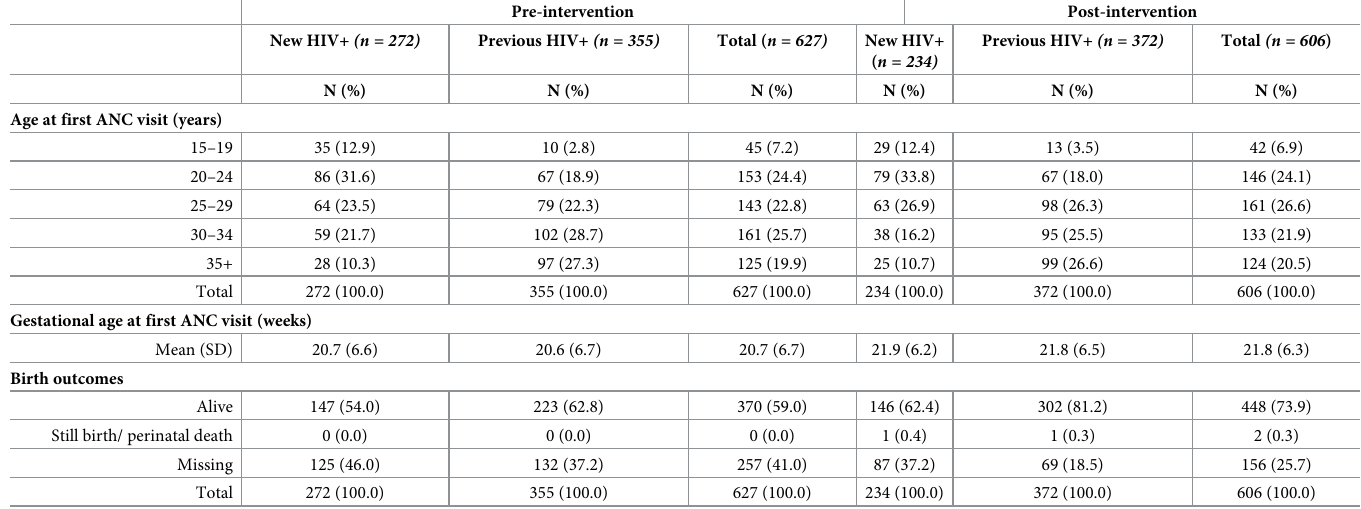
Table 1. Characteristics of the women attending PMTCT and birth outcomes pre- and post- intervention.